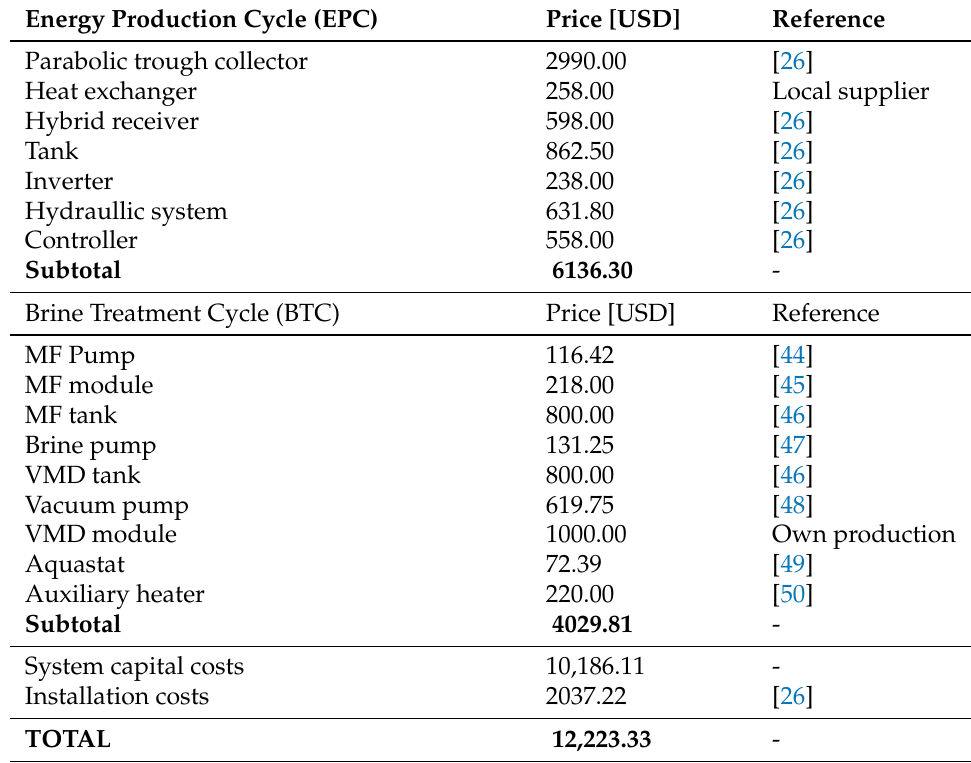
Table A2. Capital and installation costs for proposed CPVT-VMD